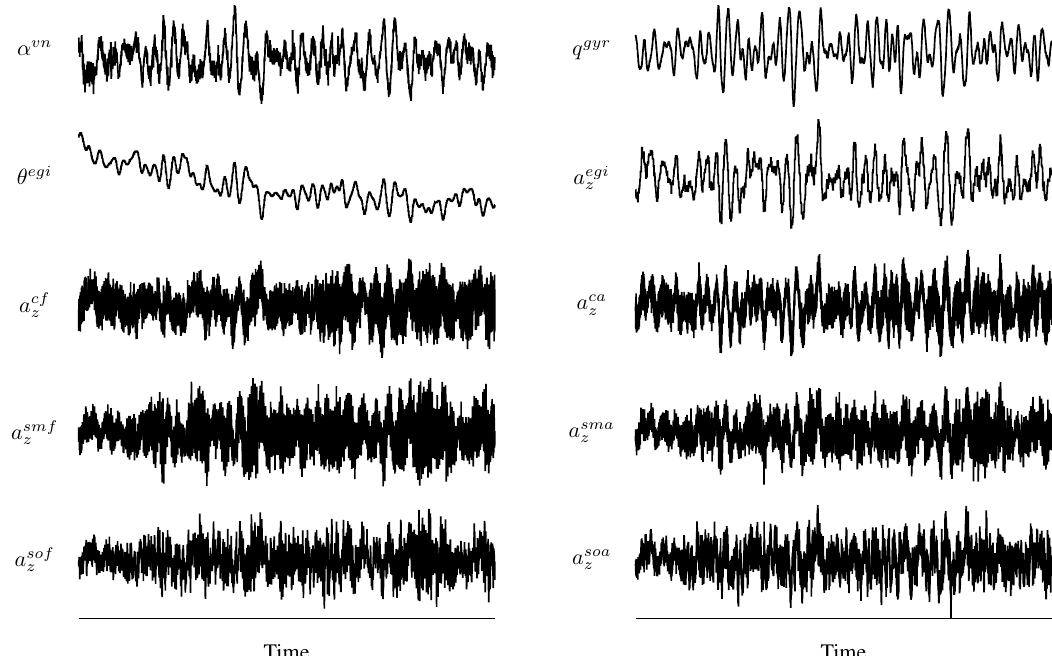
Figure 4. Measured output responses (Flight 18, FTA 506, 32% fuel, 80% flutter